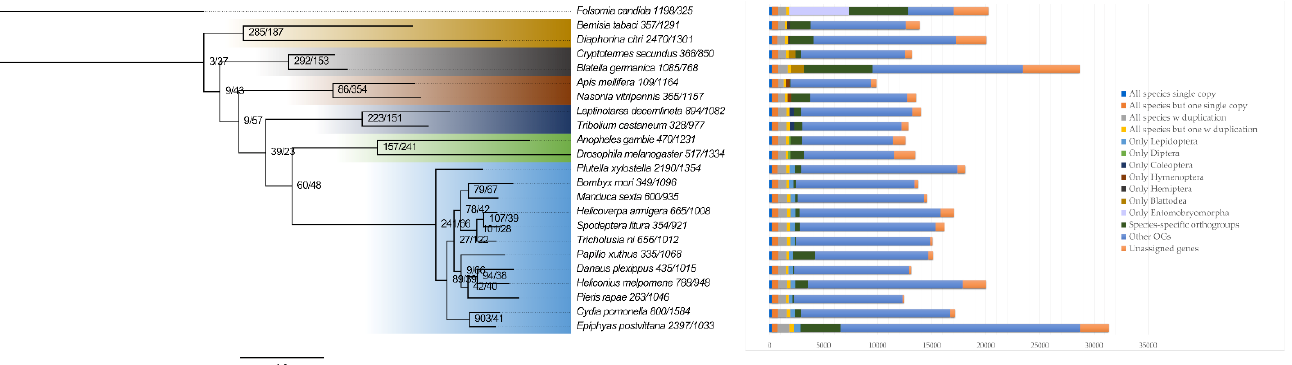
Figure 2. A phylogenetic tree of 22 insect species with Folsomia candida as an outgroup, obtained using the aligned protein sequences of 207 single-copy orthologs present in all 23 species, constructed using the ML method implemented in IQ-TREE. Branch lengths represent substitutions per site. All nodes have a bootstrap support of 100%. Numbers at the nodes and after each species name represent the number of gene families with an increase/decrease in gene number, respectively, estimated by CAFE. On the right, each bar shows the total gene counts per species grouped in the following categories: single-copy genes in all 23 species and in all except one species, gene duplicated in all or except one species, lineage-specific ortholog genes (in Lepidoptera, Diptera, Coleoptera, Hymenoptera, Hemiptera, Blattodea and Entomobryomorpha), species-specific ortholog genes, genes with other ortholog relationships and unassigned genes.